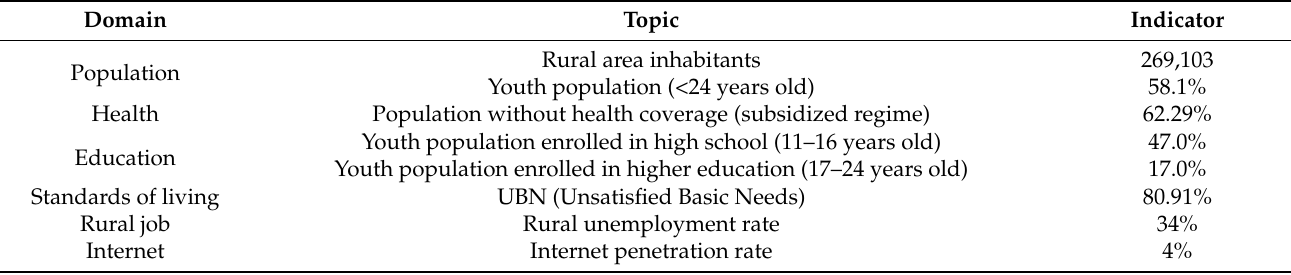
Table 2. Socio-economic indicators of Urab á